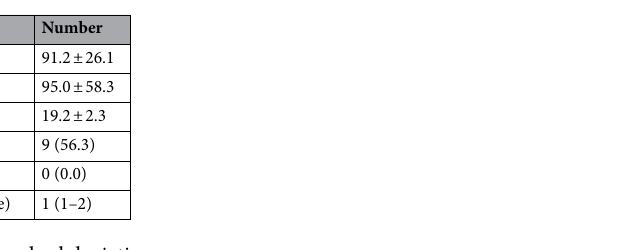
Table 2. Details of surgical data. SD standard